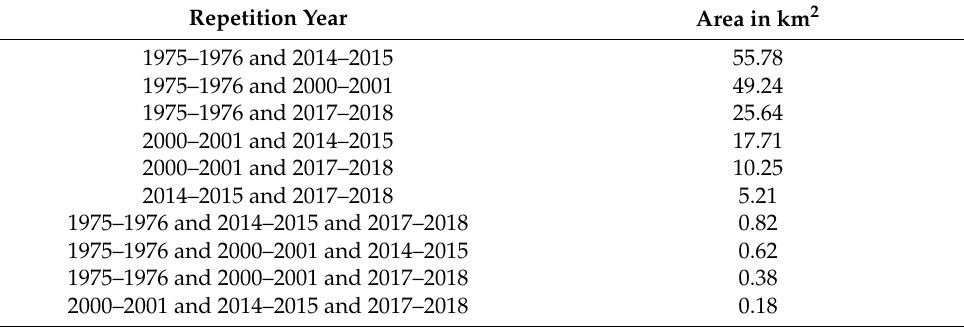
Table 3. Area estimates of shifting cultivation repetition patches in NE